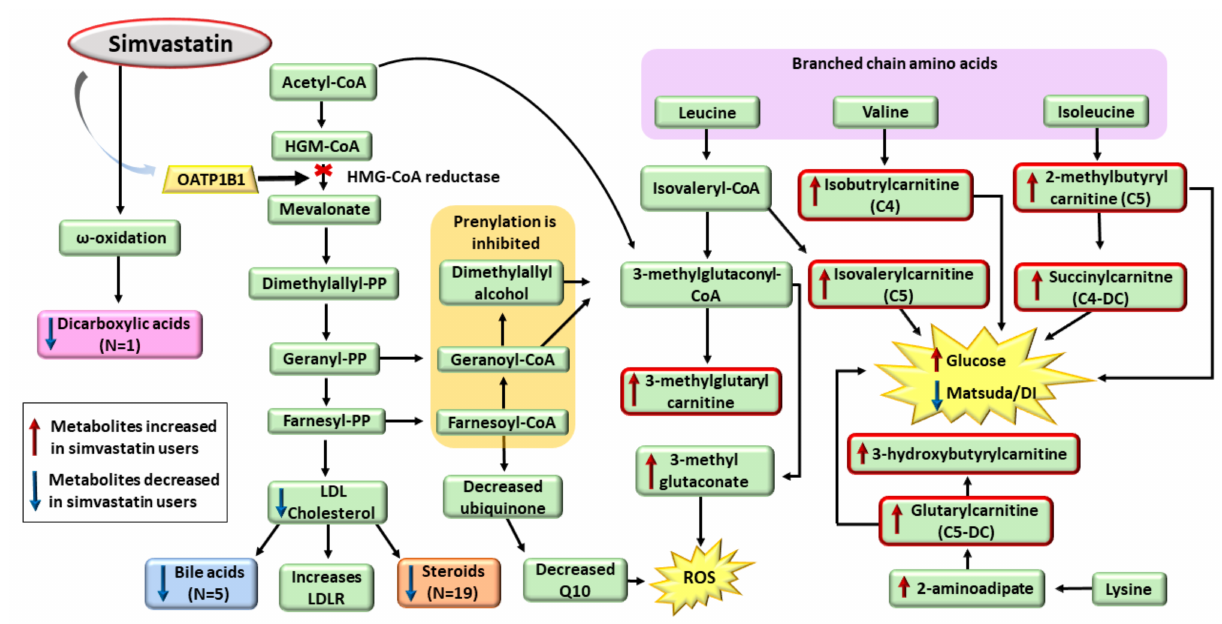
Figure 2. Effects of simvastatin treatment on steroids, bile acids, dicarboxylic acids, branched-chain amino acids, lysine and short-chain